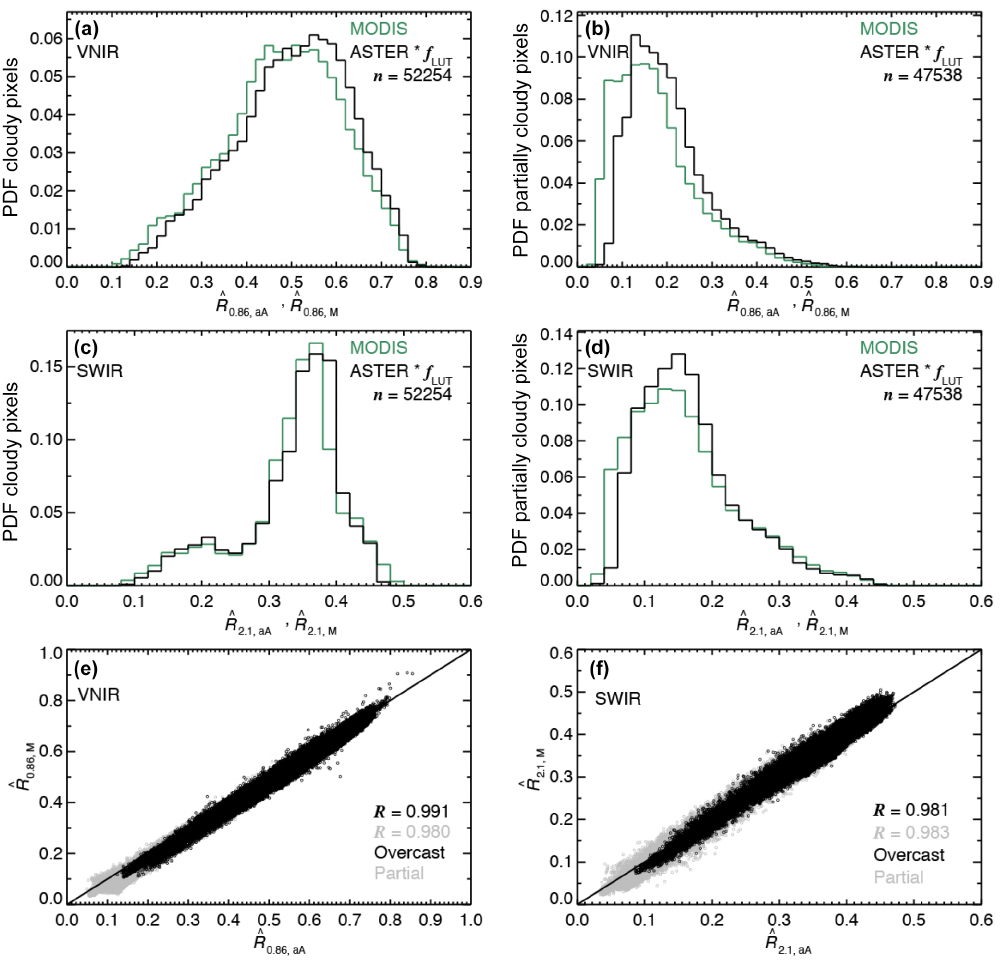
Figure 13. (a) PDFs of atmospherically corrected MODIS VNIR reflectances ( b R 0 . 86 , M ) and co-located, atmospherically corrected ASTER VNIR reflectances ( b R 0 . 86 , aA ), multiplied by the derived ratio between ASTER and MODIS LUT reflectances ( f 0 . 86 , L , see Sect. 2.3). Only overcast pixels, containing both a successful MODIS and ASTER liquid water cloud retrieval, from the 48 MBL cases are considered in the calculation of the PDFs. The number of samples ( n ) is given. (b) Same as (a) but for partially cloudy pixels. (c) – (d) Same as (a) – (b) but for b R 2 . 1 , M and b R 2 . 1 , aA sampled in the SWIR. (e) Scatter plot of b R 0 . 86 , M and b R 0 . 86 , aA (multiplied by f 2 . 1 , L ) in the VNIR. Overcast (partially cloudy) pixels are indicated in black (gray) color. The diagonal line represents the 1 : 1 line. (f) Same as (e) but for reflectances in the